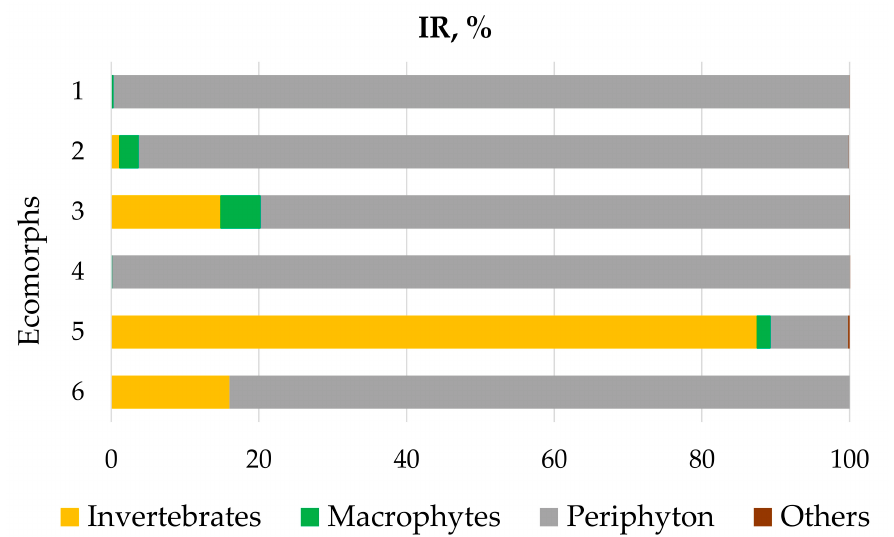
Figure 4. Food spectra (IR: the index of relative importance) of the six Garra ecomorphs from the Sore River.